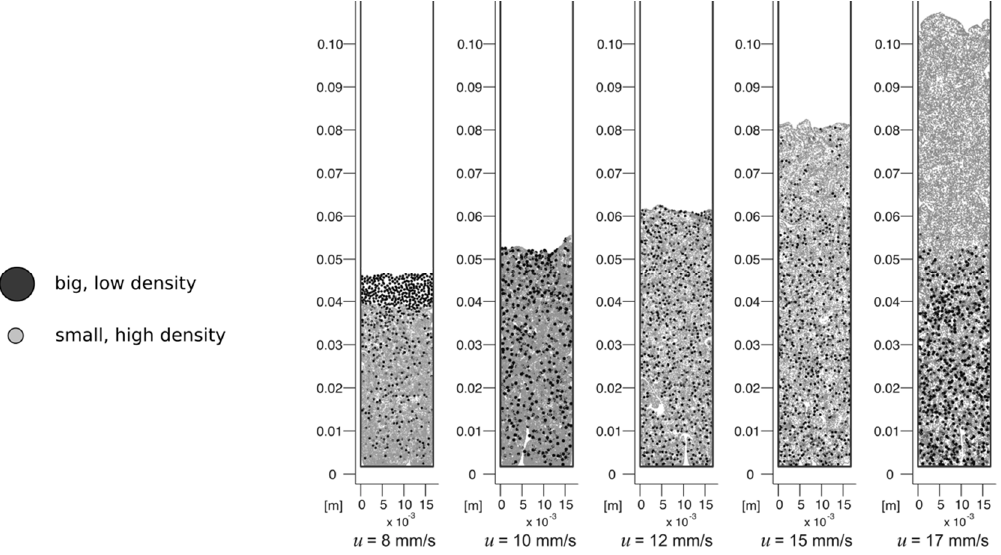
Figure 1. Simulations of the segregation and layer inversion in liquid-fluidized bed. Reprinted from phenomenon in binary liquid-fluidized beds by DEM–CFD with a drag law for polydisperse systems, 2945-2958, Copyright (2011), with permission from Elsevier [13].